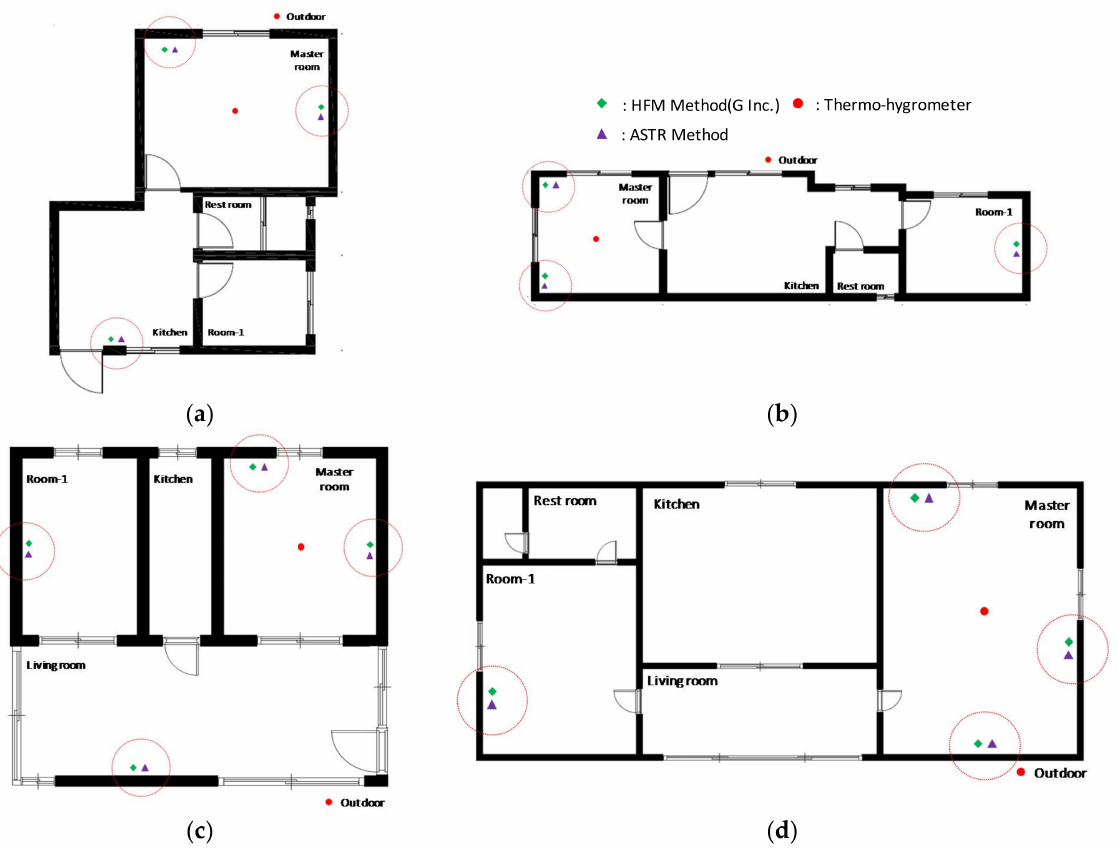
Figure 5. Measurement positions: ( a ) Case A; ( b ) Case B; ( c ) Case C; ( d ) Case